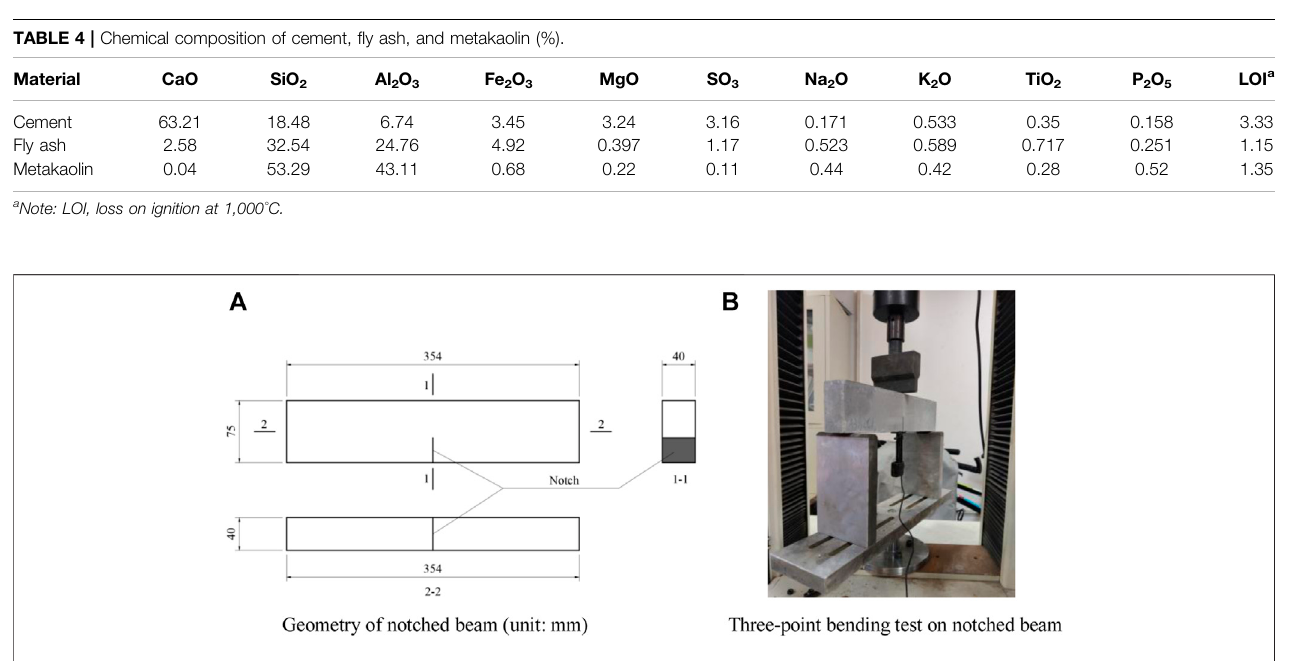
FIGURE 2 | Notched beam size and loading method. (A) Geometry of the notched beam (unit: mm). (B) Three-point bending test on the notched